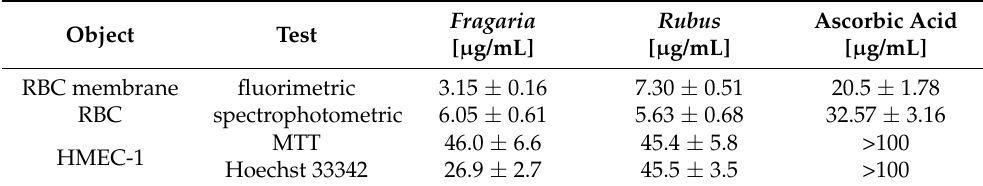
Figure 7. Viability (%) of HMEC-1 cells oxidized by 7.5 µM of AAPH for 24 h in the presence of different concentrations of extracts from Rubus and Fragaria leaves. ( A ) Viability was calculated on the basis of results obtained in MTT assay, ( B ) viability was calculated on the basis of results ob- tained in Hoechst 33342 assay. The dependences of the inhibition (%) of HMEC-1 cells oxidation on the concentration of tested extracts calculated from results of MTT ( A ) and Hoechst 33342 ( B ) assays are shown as the inserted figures.